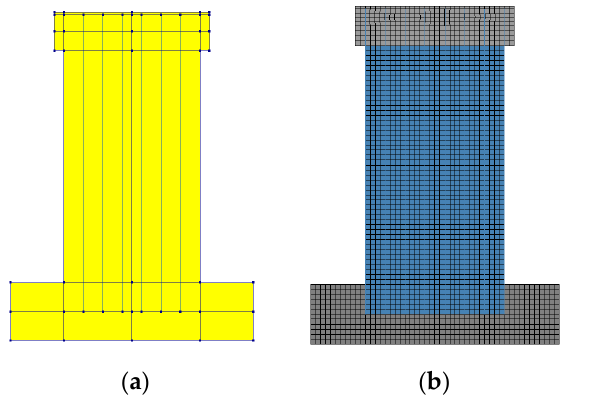
Figure 3. GSPCW wall models in DIANA: ( a ) model schematic; ( b ) meshed model with loading conditions and constraints.